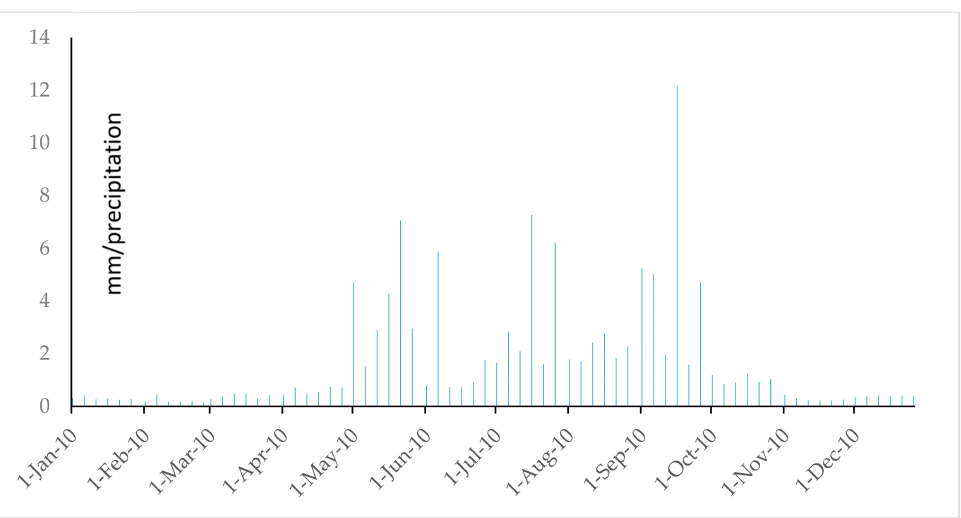
Figure A37. Precipitation of Denko County in 2009.